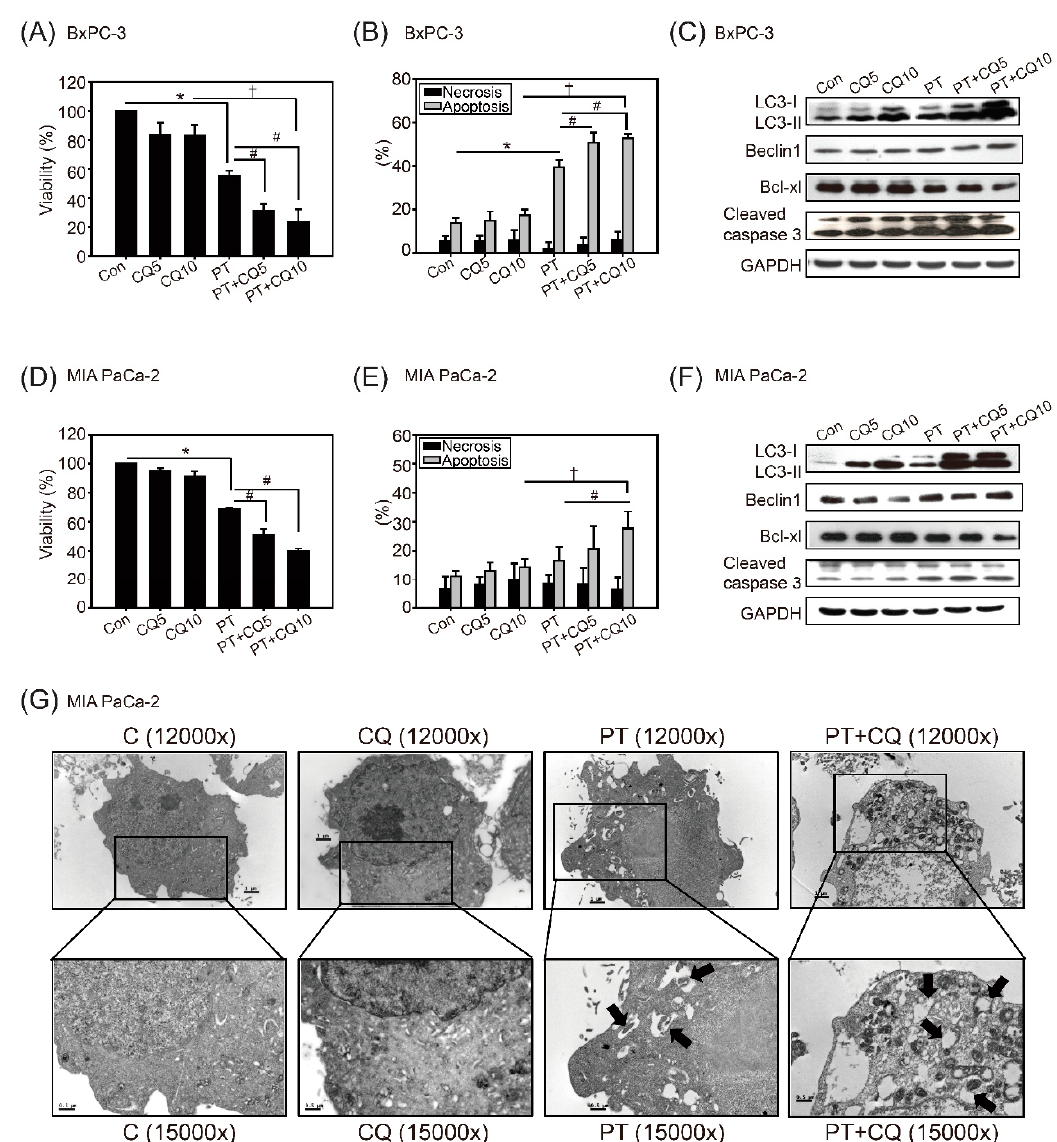
Figure 3. Synergistic cytotoxic effects of PT combined with the autophagy inhibitor chloroquine (CQ). Dose-dependent cytotoxic effects of CQ (5, and 10 µ M) and PT (100 µ M) treatment alone or in combination (PT + CQ) in ( A ) BxPC-3 cells and ( D ) MIA PaCa-2 cells for 48 h, analyzed via MTT assay. The data are presented as the means ± SEM of three inde-